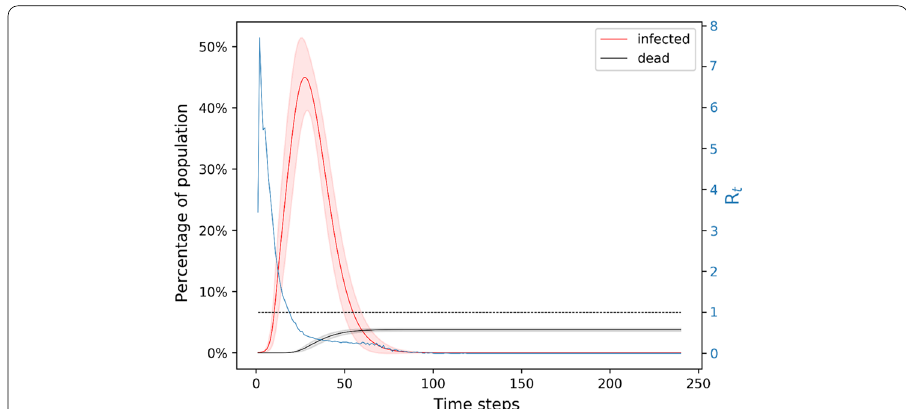
Fig. 3 Unmitigated spread of the disease in the network model. The plot shows for each time step the number of nodes in the network that are infected in red color and the number of nodes that are dead in black color. The reproduction number is shown in blue with the scale shown on the right y-axis. The x-axis gives the timesteps. The shaded area around the line plots is marked by the standard deviation obtained by running the simulation ~ 1000 times. The disease completes its course in ~ 80 days, infecting about 70% of the